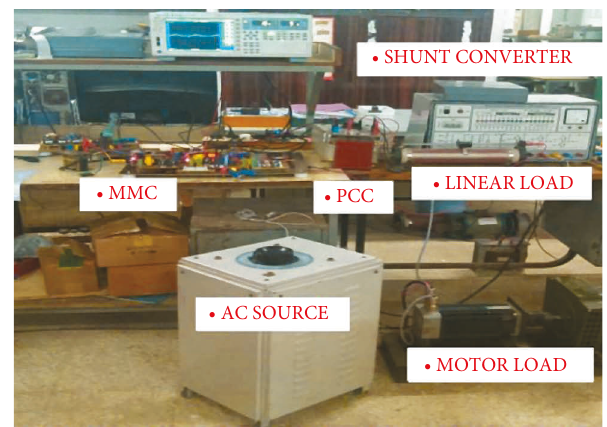
Figure 9: Hardware implementation of the MMC-based